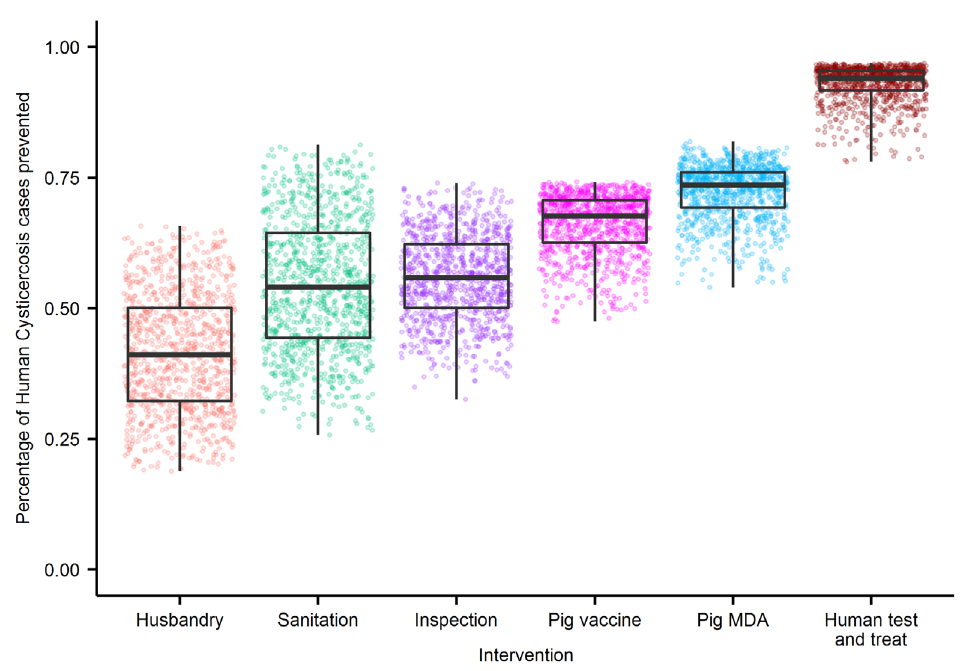
Figure 1. Impact of single interventions on the number of human cysticercosis cases. Box and whiskers represent the range of impact estimates from 1000 sensitivity draws of intervention efficacy parameters, the midline represents the median impact (on the proportion of Human Cysticercosis cases prevented), the hinges the 25 th and 75 th percentiles, and the whiskers the range. Points show individual run outputs. Due to the large amount of uncertainty in parameters estimates, the impact of parameter estimates was explored separately (see Figure 4 in Winskill et al . 37 ). This figure has been reproduced under the Creative Commons Attribution 4.0 International License (CC BY 4.0) from Winskill et al. 37